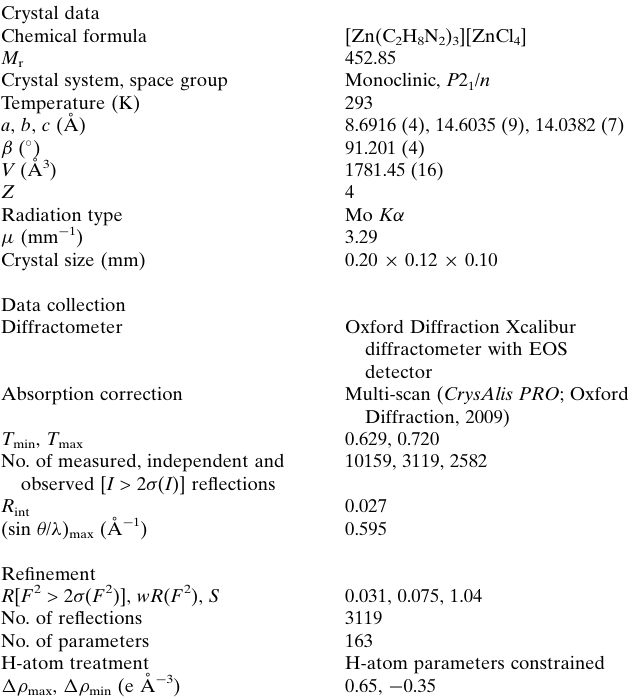
Table 2 Experimental details. Crystal data Chemical